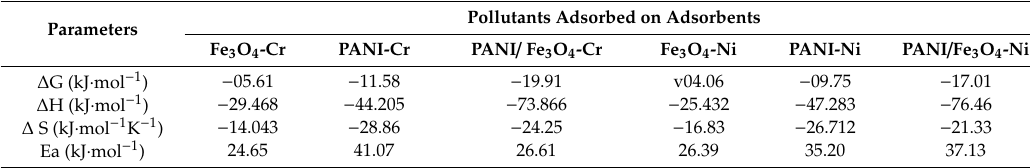
Table 3. Thermodynamic properties of